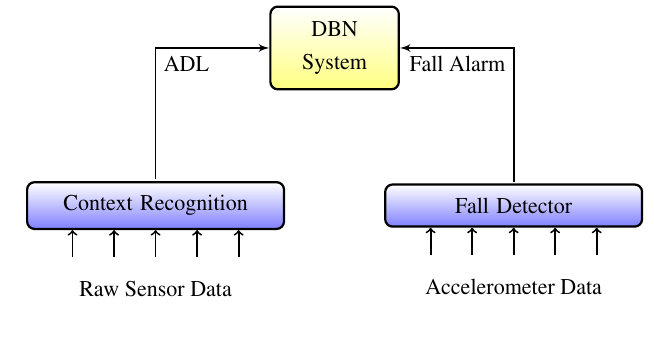
Table 1. Preliminary list of